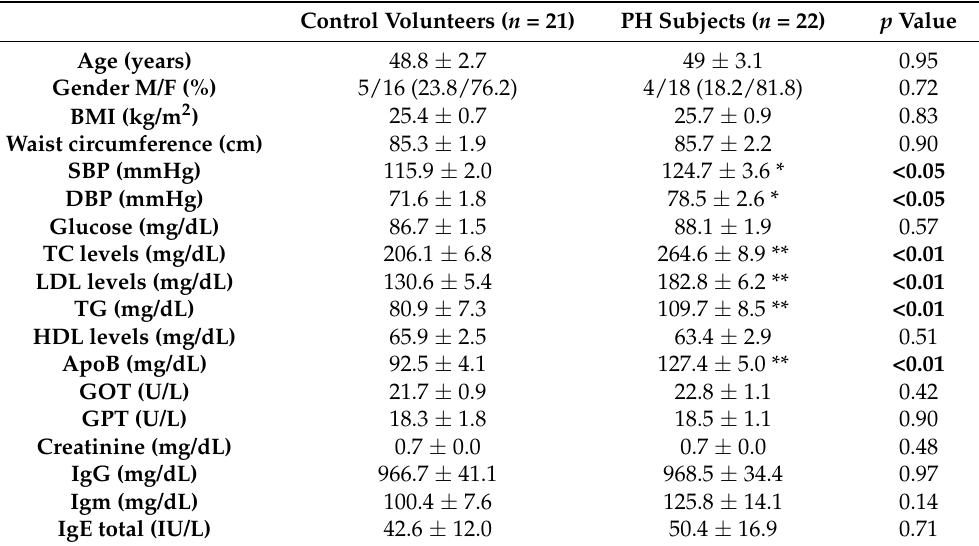
Table 1. Demographic and clinical features of patients and age-matched